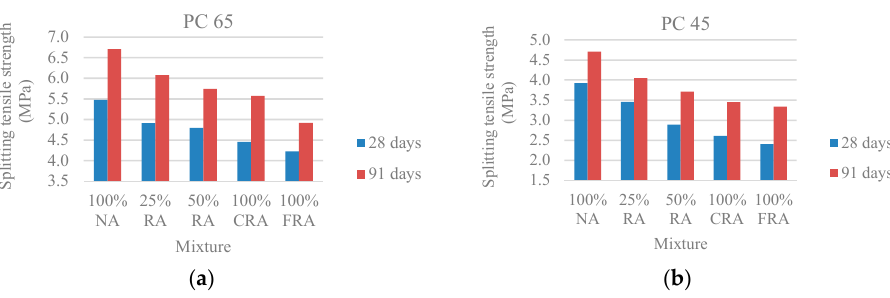
Figure 6. ( a ) Splitting tensile strength at 28 and 91 days (PC 65); ( b ) Splitting tensile strength at 28 and 91 days (PC 45).